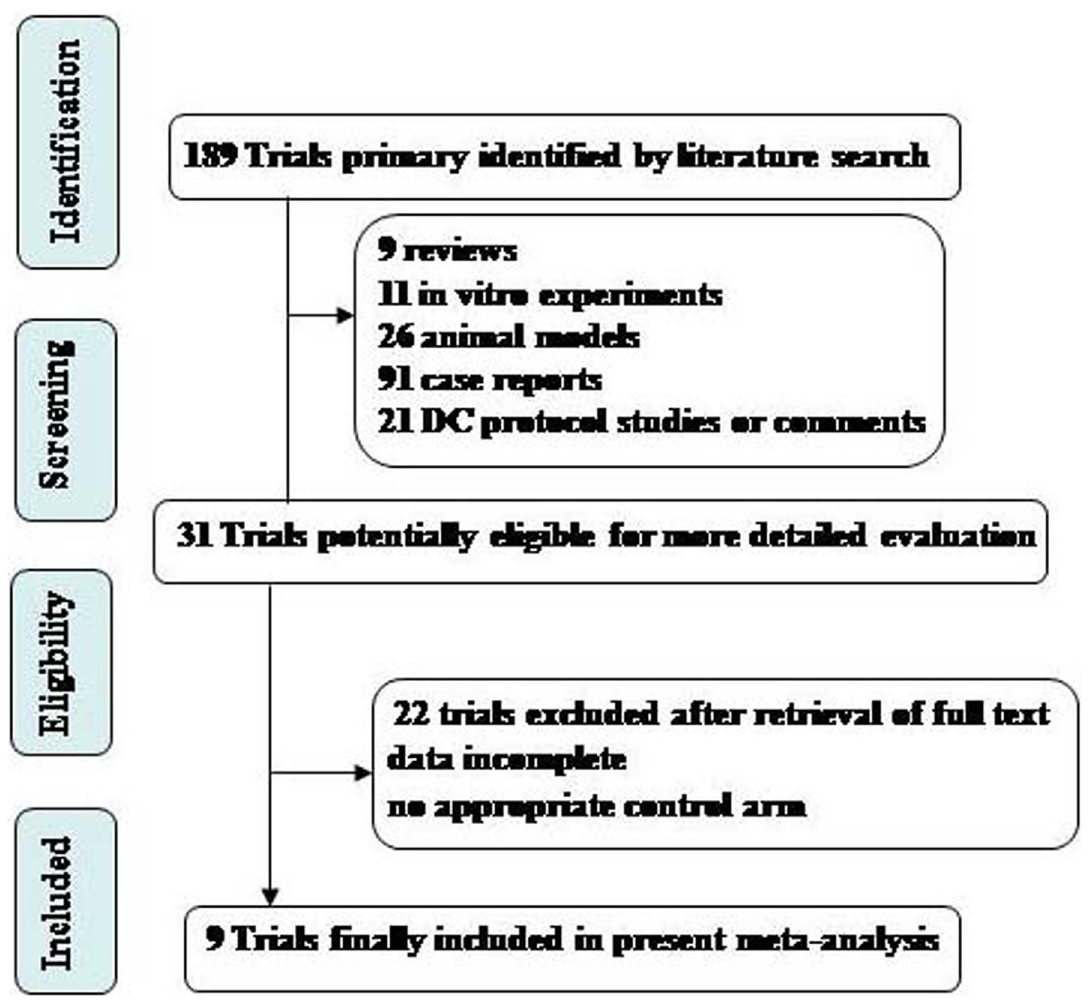
Figure 1. Flow diagram showing record identification, screening and study inclusion process.